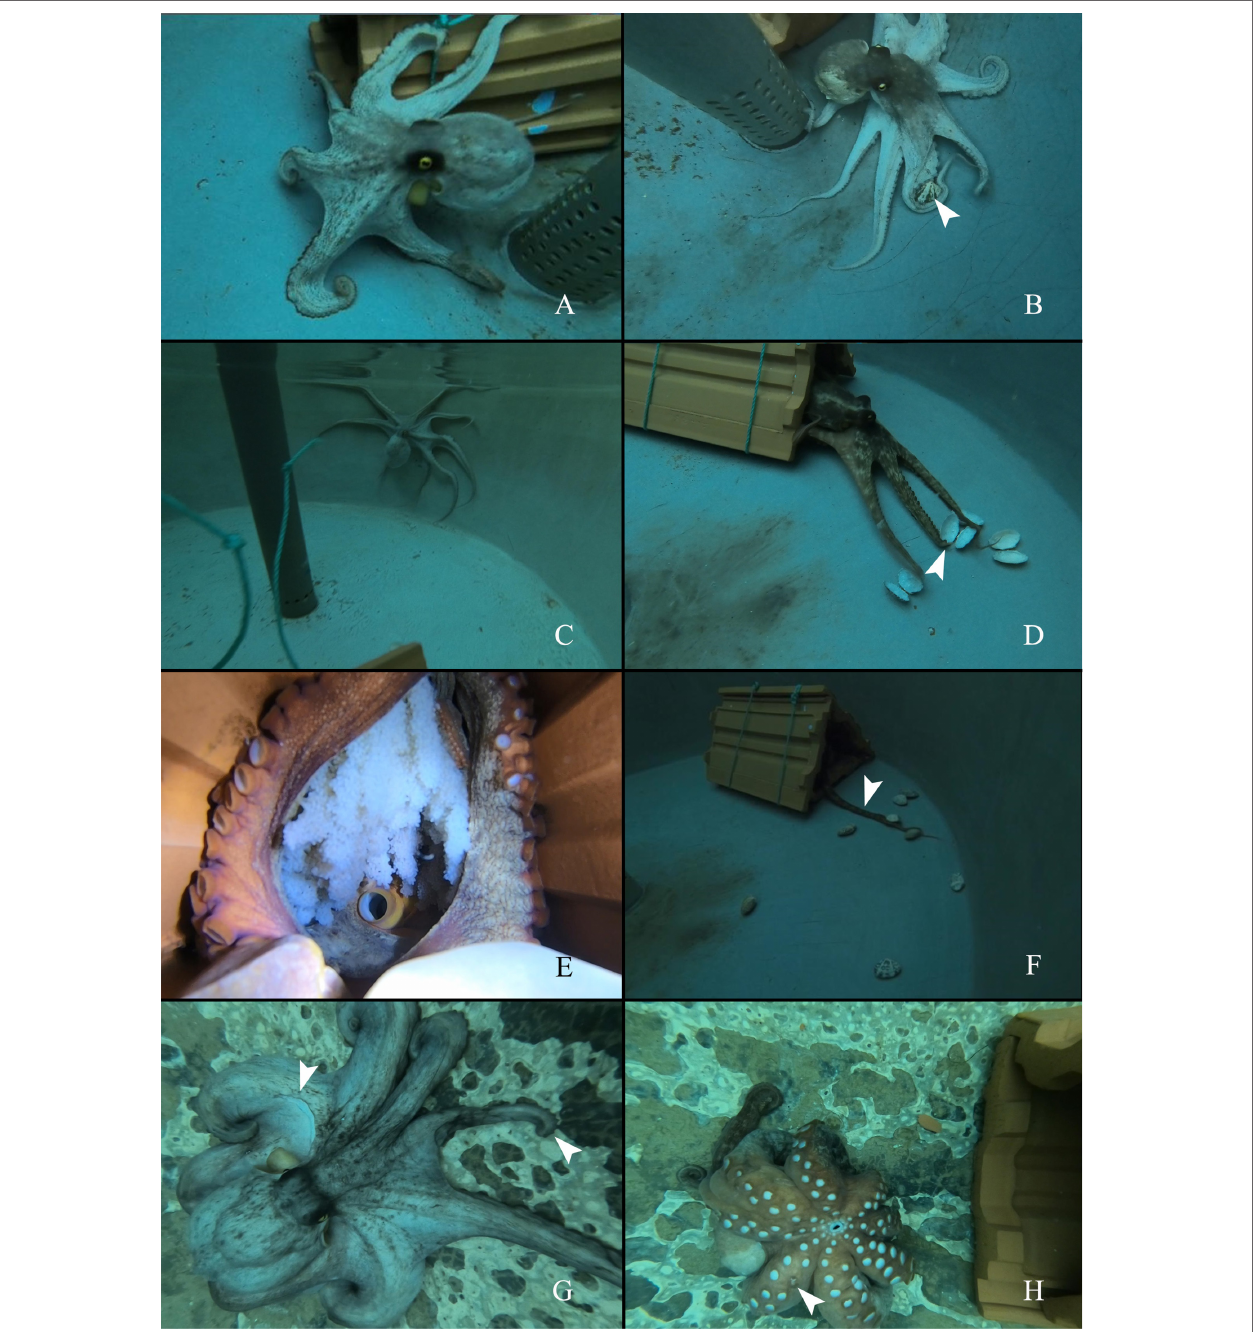
FIGURE 1 | The appearance and behaviors of O.sinensis in control, starvation and senescence groups. (A) O.sinensis in control group spends time outside of its home den. (B) O.sinensis in control group attacks the clams (several clams are restrained under the interbranchial web). White arrow head indicates the clam. (C) O.sinensis in starvation group is active outside of its home den. (D) O.sinensis in starvation group attacks the empty shells of clams. White arrow head indicates the missing arm tip. (E) A brooding female. (F) O.sinensis in senescence group stays inside their home den, uses arm to grasp clams. White arrow head indicates the arm stretches out the den. (G) The appearance of a senescent female. White arrow heads indicate a missing patch of skin and a missing arm tip. (H) A senescent female cannot turn over (one day before death). White arrow head indicates a missing